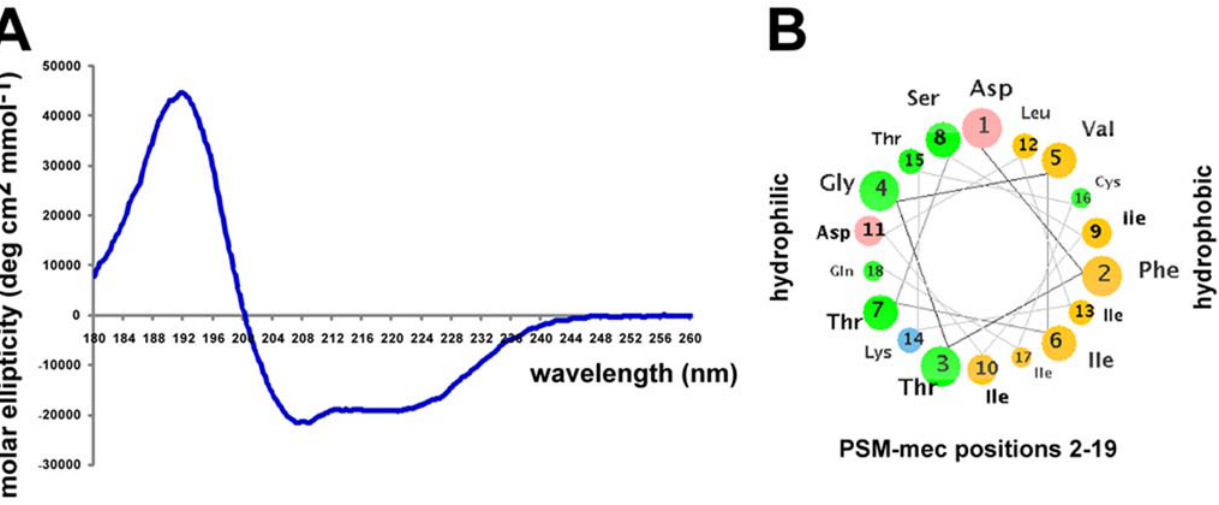
Figure 4. Physico-chemical characteristics of PSM-mec. (A) CD spectrum. Computation of a -helical content gave the following results: 59.3% (CONTINLL), 56.2% (SELCON3), 63.7% (CDSSTR). (B) Arrangement of PSM-mec (positions 2–19) in an a -helical wheel showing the amphipathy that is typical for PSMs: a hydrophilic side (left) and hydrophobic side (right).